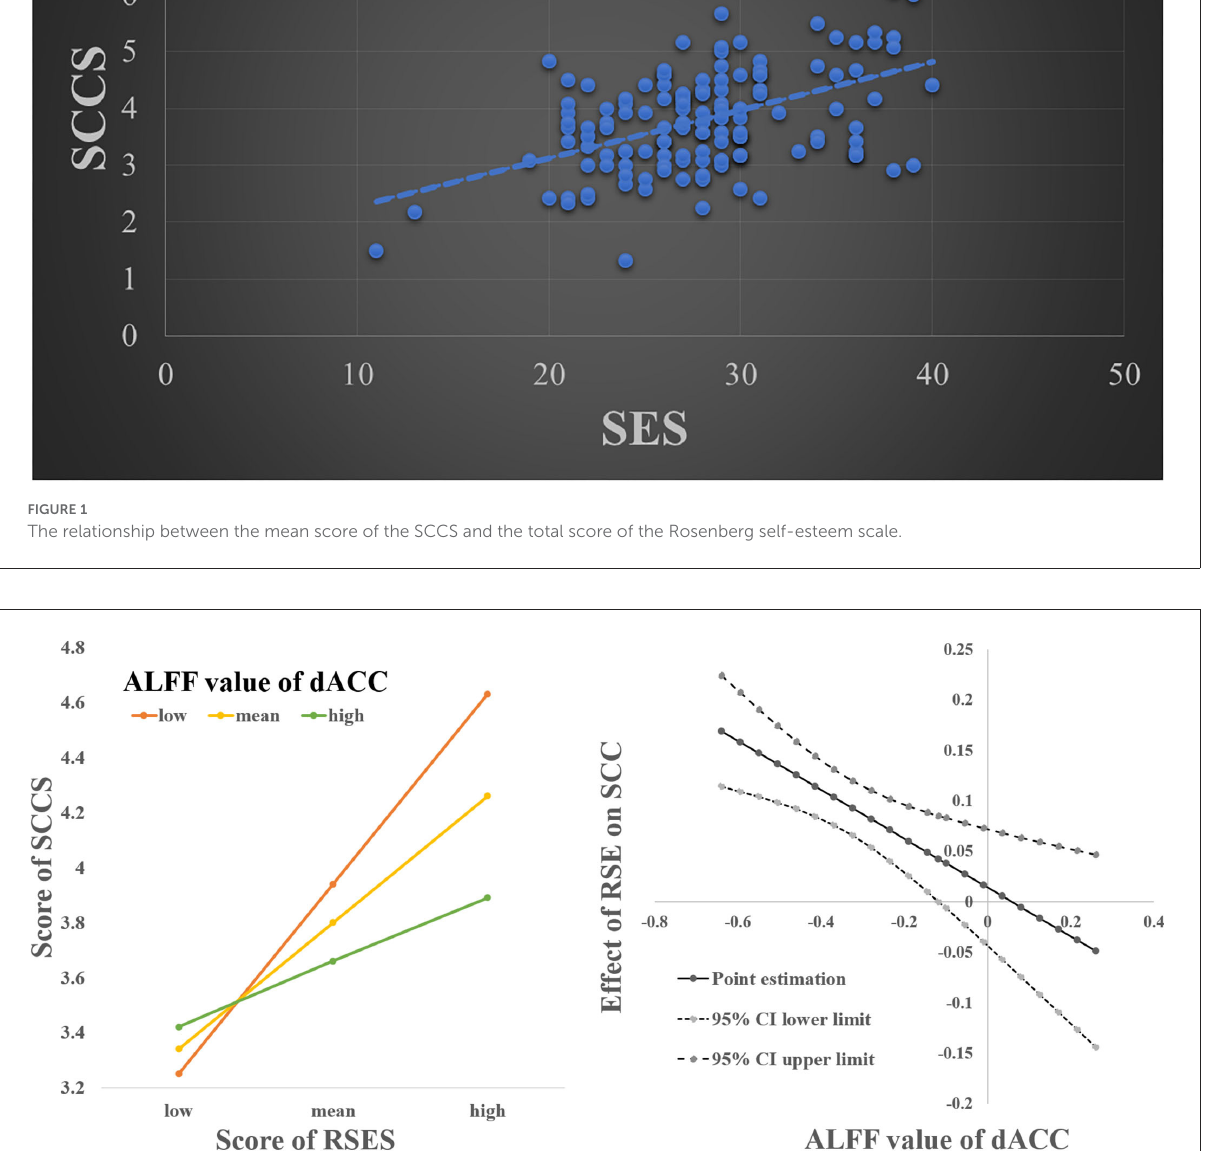
which includes the ROI. Considering that the spontaneous activities of certain brain regions can reflect their preparing roles in processing information (Raichle and Mintun, 2006; Fox and Raichle, 2007; Raichle, 2010), the right dACC might be an inner gauge of relatedness, which makes it more active in the resting